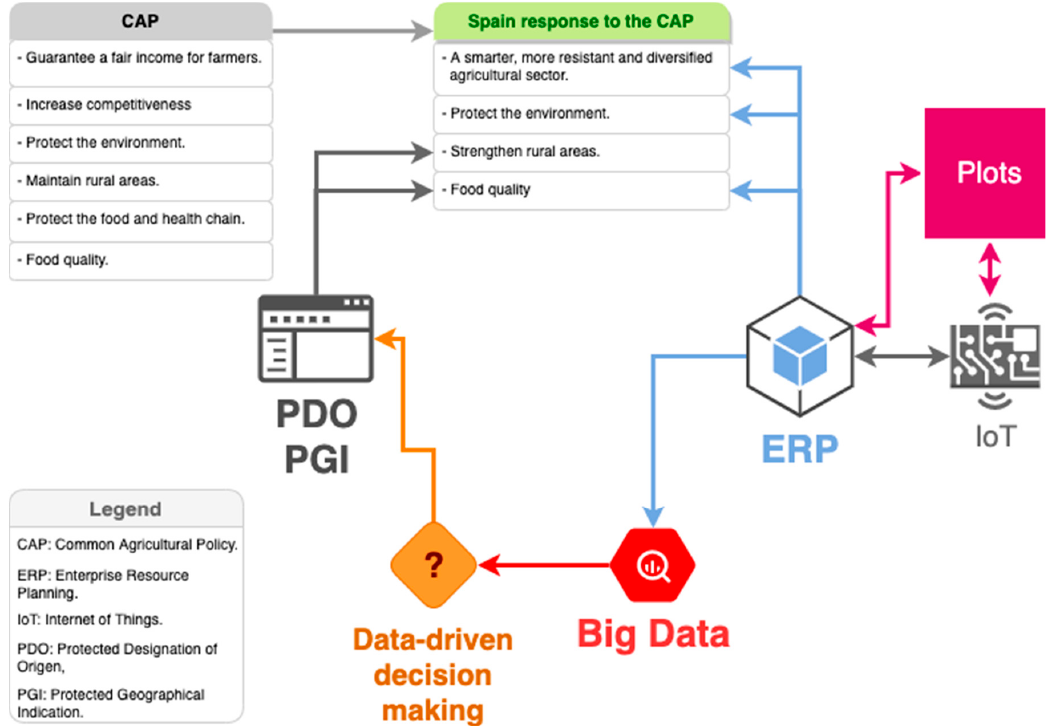
Figure 1. Interconnections among CAP objectives, PDO / IGP and the coordination of their several aspects through an ERP.